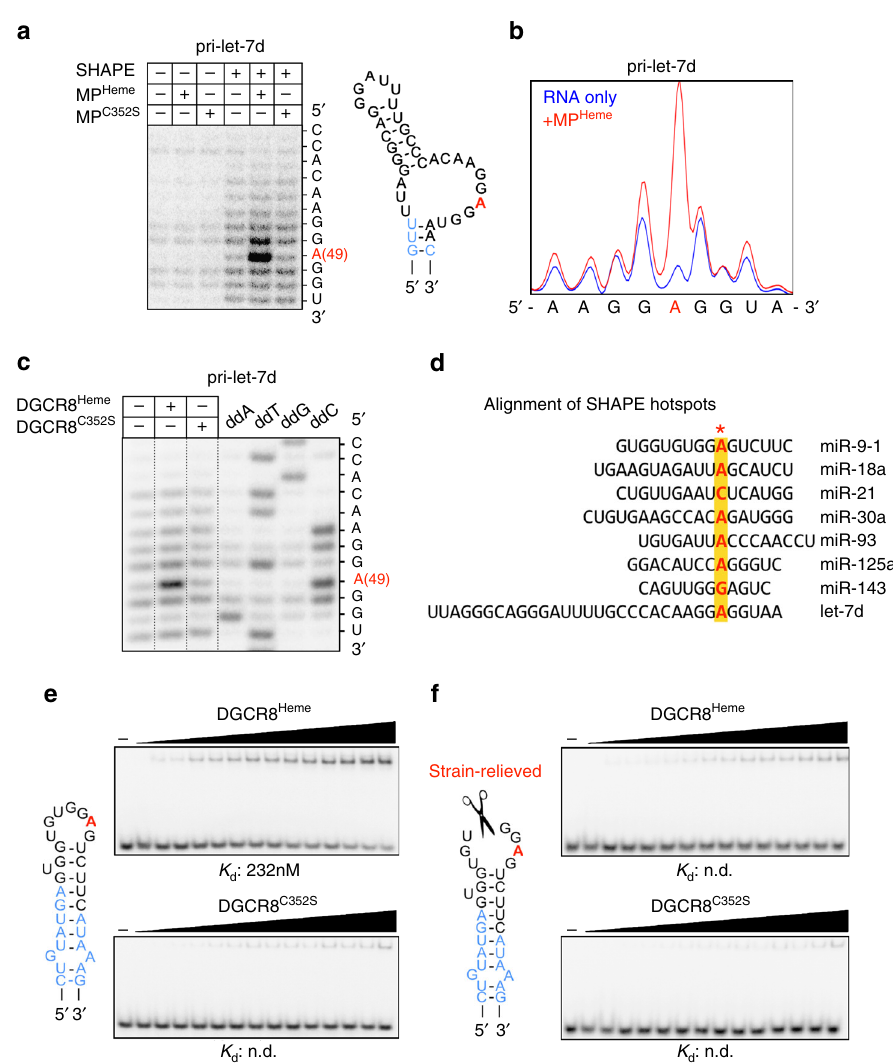
Fig. 5 Heme binding allows DGCR8 to recognize the terminal loop structure. a SHAPE analysis of pri-let-7d, showing hyperreactivity associated with MP Heme binding. Secondary structure diagram (right) depicts the position of the SHAPE “ hotspot ” (red). Mature sequence is shown in light blue. Control reactions containing no SHAPE reagent (benzoyl cyanide) are shown in lanes 1 – 3. b SHAPE analysis of pri-let-7d with MP Heme by capillary electrophoresis. c SHAPE analysis of pri-let-7d with DGCR8. Only the reactions containing the SHAPE reagent are shown, and (unshifted) nucleotide marker lanes are shown to the right. d Diagram summarizing SHAPE results for a series of pri-miRs, aligned according to the site of highest reactivity marked with red font on yellow background. The sequence of the apical fragment released by Dicer is shown for each miR. SHAPE gels for additional miRs are shown in Supplementary Fig. 5c – i. e , f EMSAs comparing the binding af fi nities of DGCR8 Heme and DGCR8 C352S for e pre-miR-9-1 and f pre-miR-9-1 containing a central break in the terminal loop. Diagrams of RNA sequences are shown to the left. Protein concentrations are (left to right): 33, 50, 67, 83, 100, 117, 133 , 150, 167, 183, 200, 217, 233, and 250nM. All secondary structure diagrams were designed using